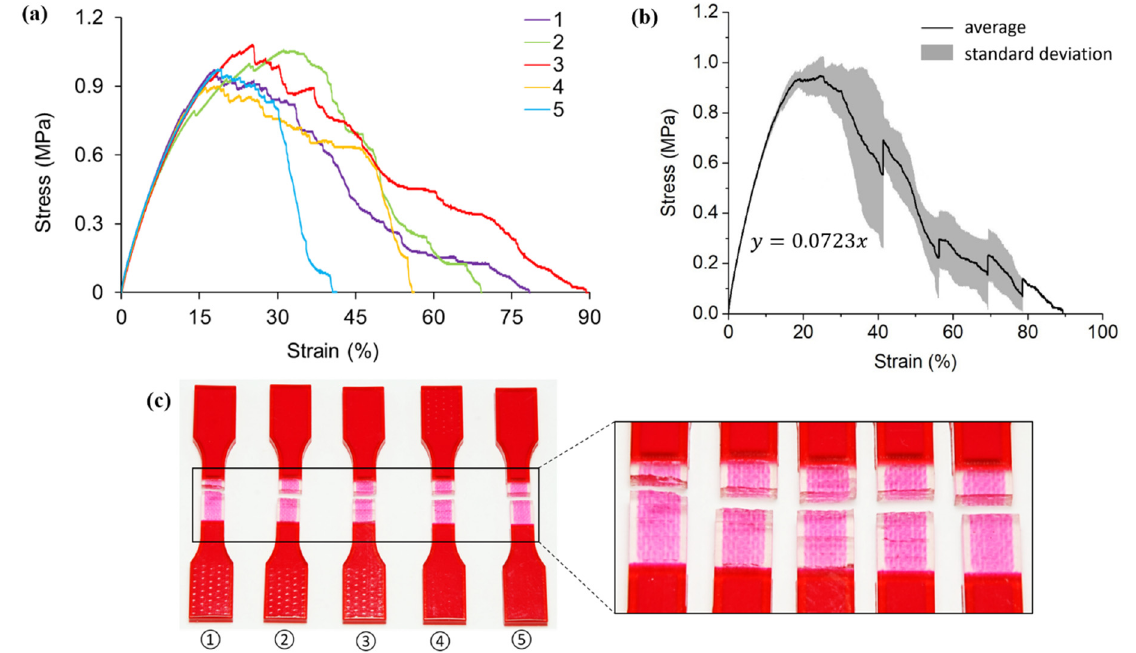
Figure 9. ( a ) Stress-strain curves obtained from tensile testing tests on hybrid case five (mostly horizontal second order) samples; ( b ) average tensile stress-strain curve and standard deviation of all five testings; ( c ) pictures of failed tensile samples with magnification at the locations of fracture.